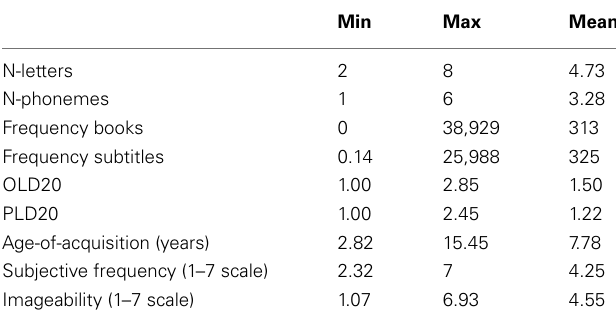
Table 1 | Characteristics of the words used in the